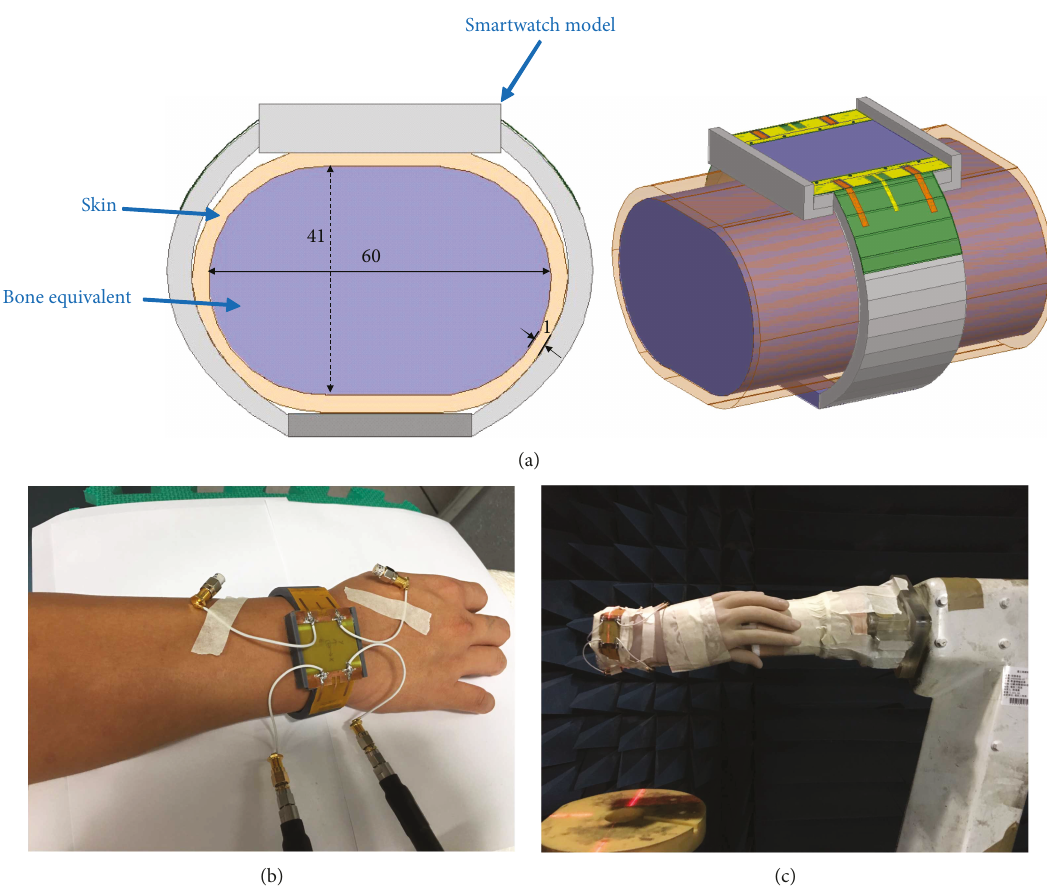
Figure 11: (a) Simulation con fi guration when using a wrist. (b) Photograph of the human wrist measurement. (c) Photograph of the phantom hand measurement in an anechoic